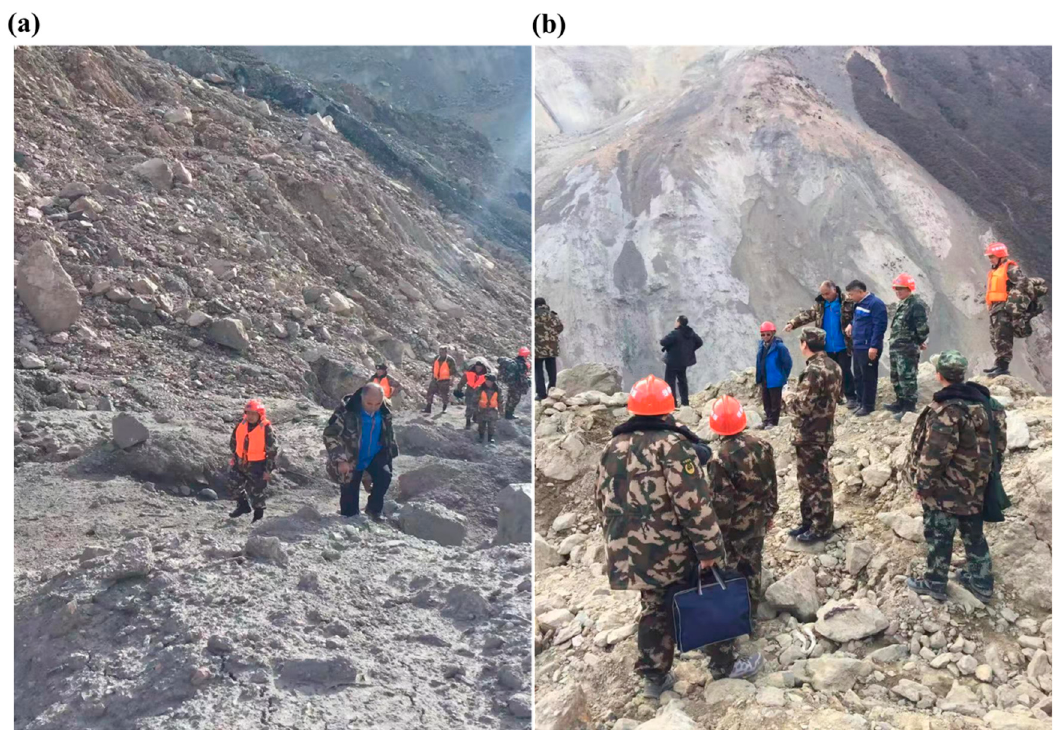
Figure 4. Field survey of the Baige landslide. Engineering geologists and hydrologists carried out a field survey of the Baige landslide during ( a ) 4 November, 2018 and ( b ) 5 November, 2018.